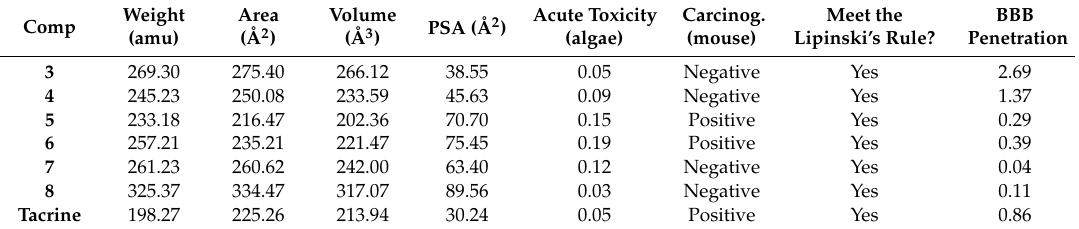
Table 1. Values of weight (amu), area (Å 2 ), volume (Å 3 ), polar surface area (PSA, Å 2 ), acute toxicity, Lipinski’s rule and blood–brain barrier (BBB) calculated for compounds (3) – (8) . Comp